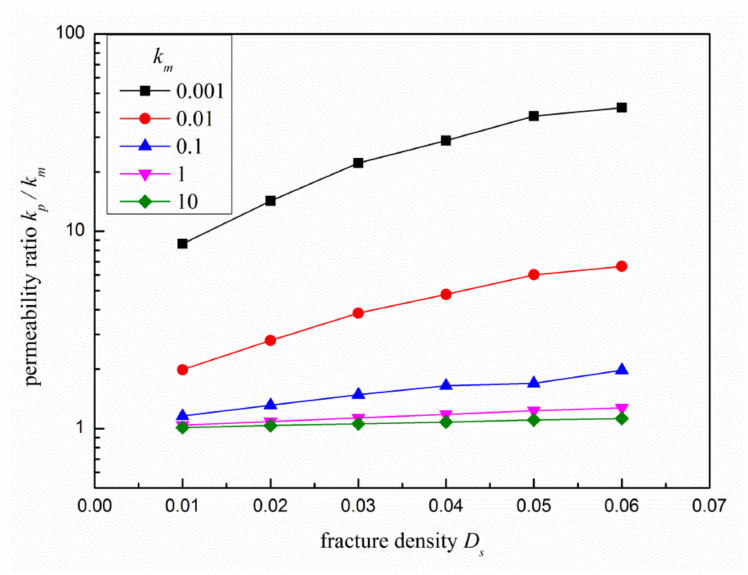
Figure 10. The effect of fracture on matrix with different fracture